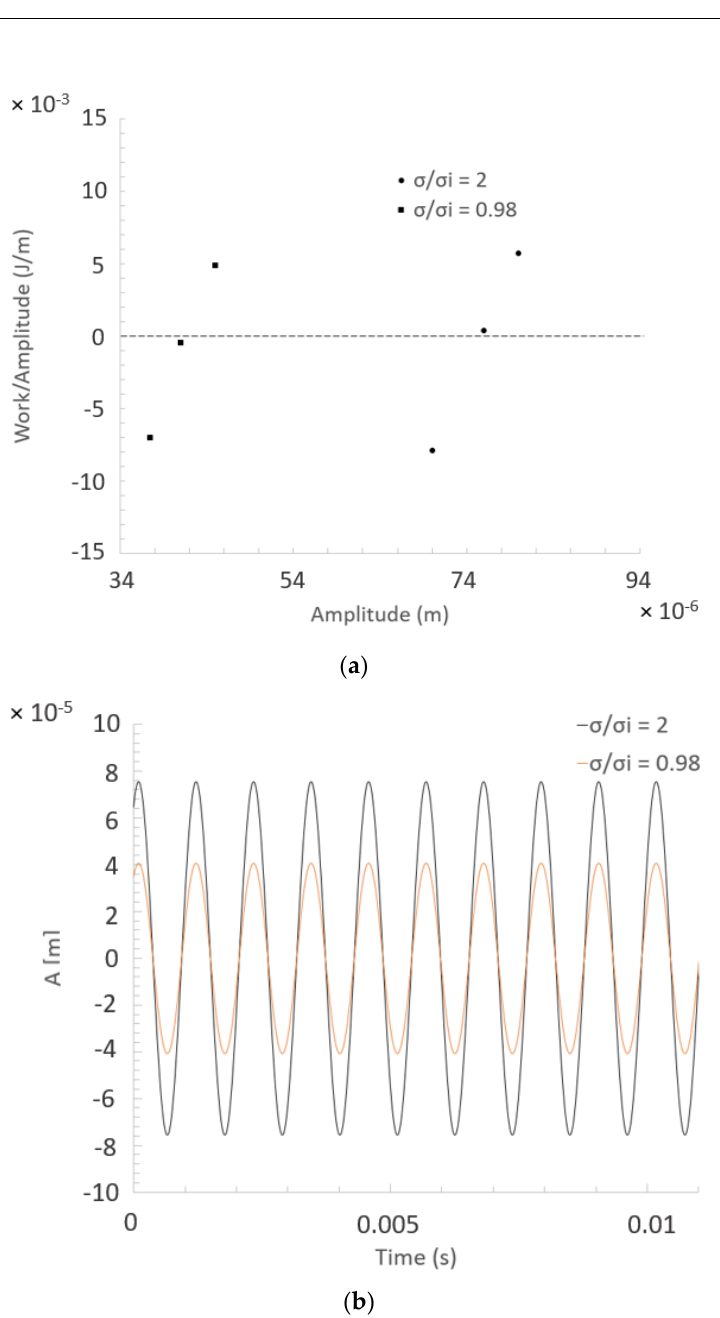
Figure 7. Predicted maximum vibration amplitudes at the trailing edge corresponding to the points with zero work located near the dashed horizontal line ( a ); and displacement time histories of the first torsion mode in resonance with the von Karman vortex street for no cavitation and incipient cavitation regimes ( b ).